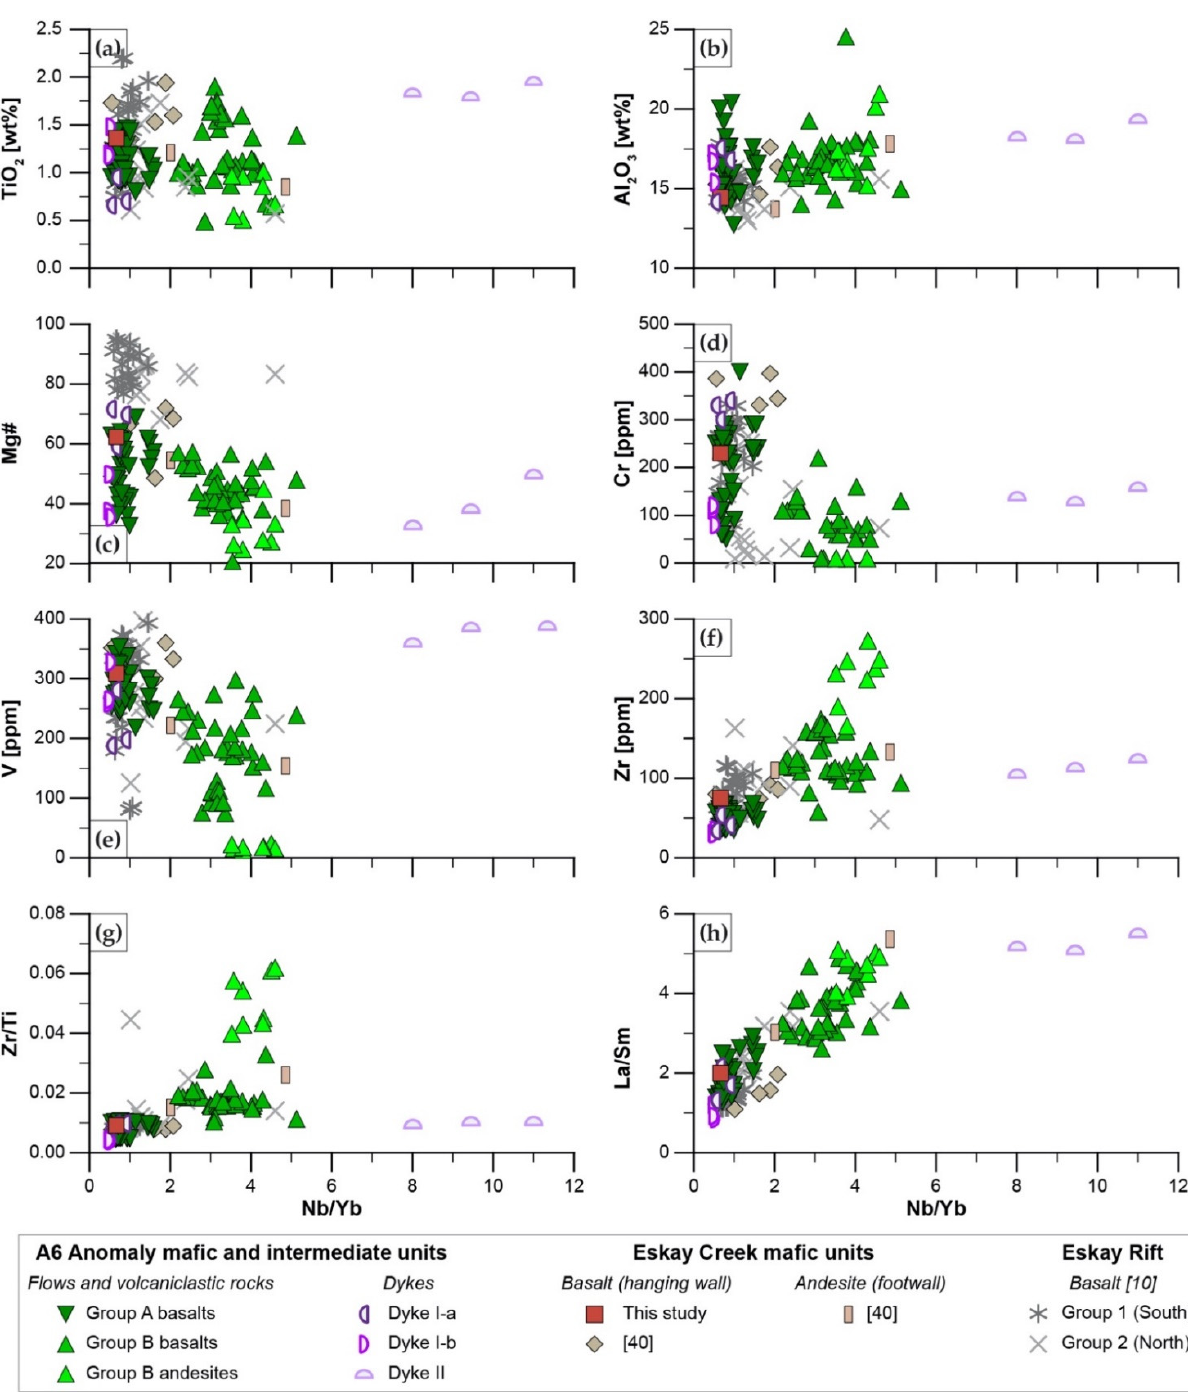
Figure 11. Bivariate plots of mafic lithologies from the A6 Anomaly, Eskay Creek (with data from [40], and this study) and the Eskay rift [10] for selected major, minor and trace elements, and element ratios versus N/Yb. ( a ) TiO 2 [wt%], ( b ) Al 2 O 3 [wt%], ( c ) Mg# (Mg# = 100 × [molar (Mg 2+ /(Mg 2+ + Fe 2+ )]), ( d ) Cr [ppm], ( e ) V [ppm], ( f ) Zr [ppm], ( g ) Zr/Ti, ( h ) La/Sm. Note: Group A basalts from the A6 Anomaly and Group 1 basalts from the Eskay rift [10] are almost identical in their composition and hence overlap in most plots resulting that data of Group 1 are partially obscured by Group A basalts since focus is on lithologies of A6 Anomaly.